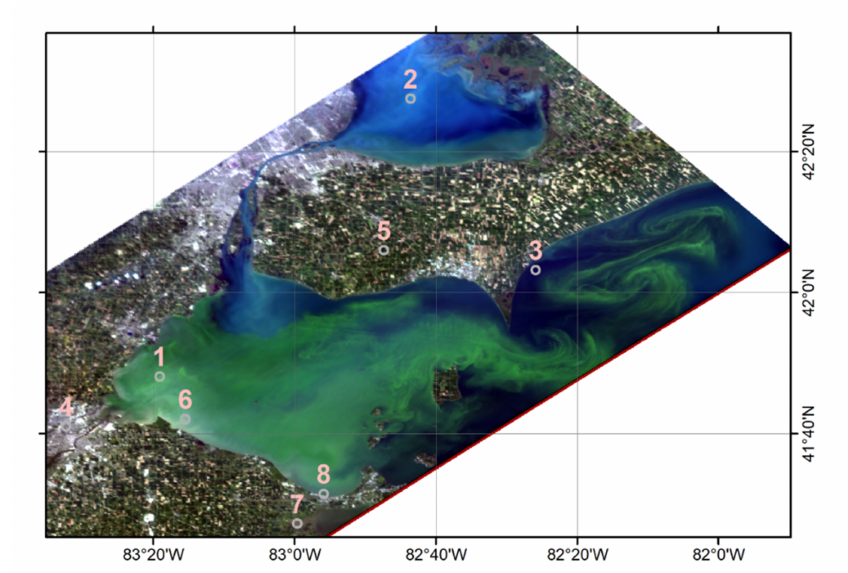
Figure 9. Map of extraction points for exemplary spectral signatures. The points represent: (1) one of the highest chlorophyll values, (2) one of the highest phycocyanin values with low chlorophyll value, (3) one of the darkest water points with low chlorophyll and phycocyanin values, (4) urban surface in Toledo without vegetation, (5) green fields on the peninsula between Lake Erie and Lake St. Clair, (6) near the Toledo water pump intake, (7) in the western corner of Sandusky bay with medium chlorophyll and very low phycocyanin values, and (8) near the Ottawa County water pump intake. (Data source: NASA Ocean Color